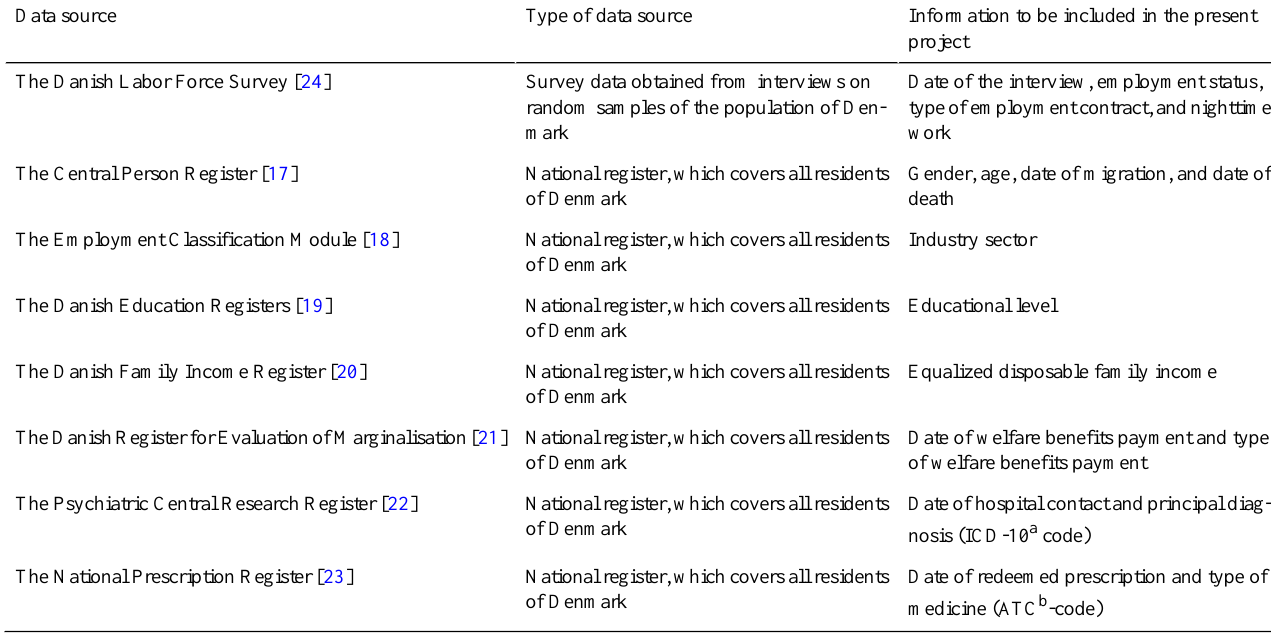
Table 1. The data sources of the